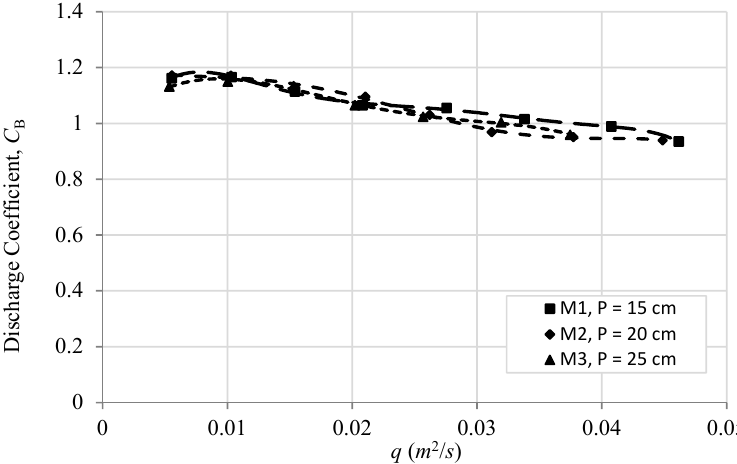
Figure 14. Discharge coefficient, C B , vs. unit discharge, q, for models M1, M2, and M3.